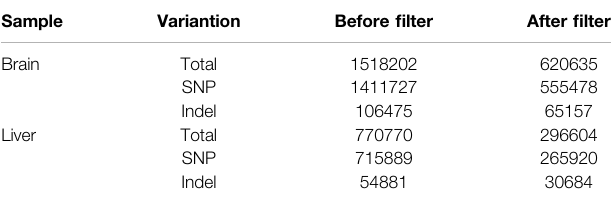
TABLE 2 | Statistical table of variation number before and after fi